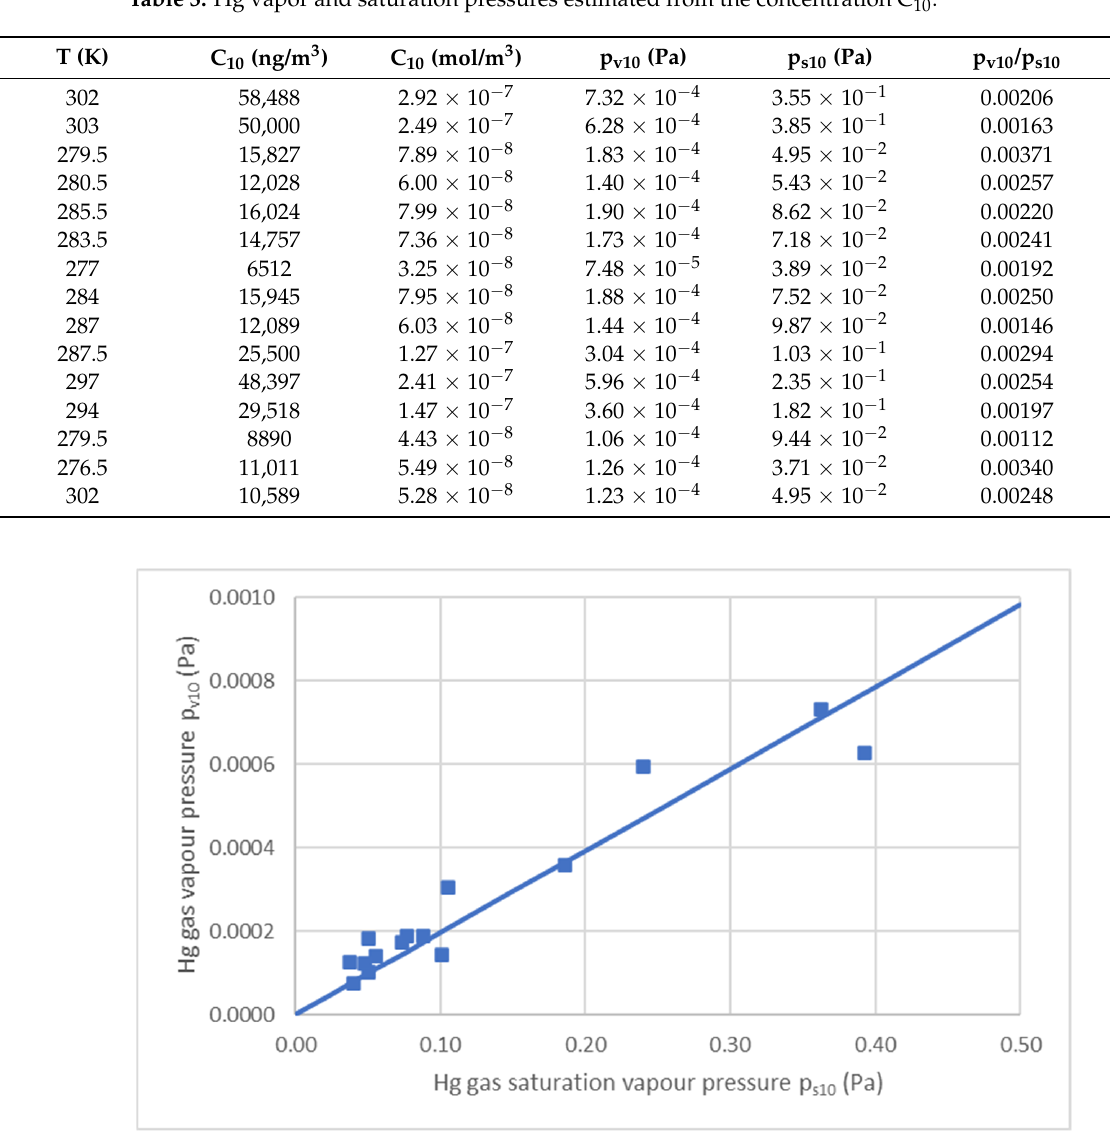
Table 3. Hg vapor and saturation pressures estimated from the concentration C 10 .